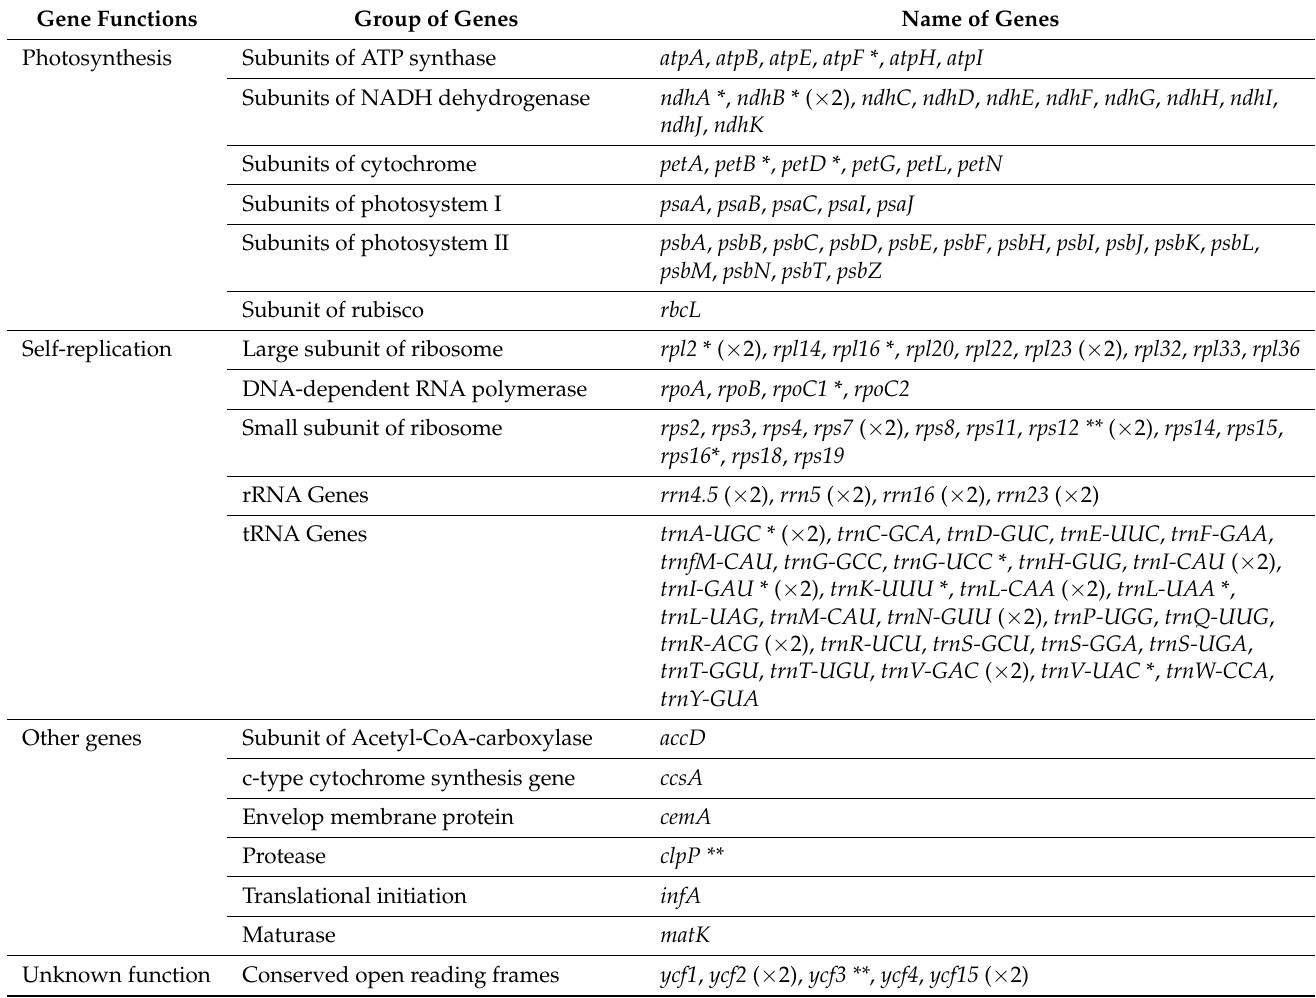
Table 4. Genes present in the plastomes of 10 taxa of sect. Drymosphace